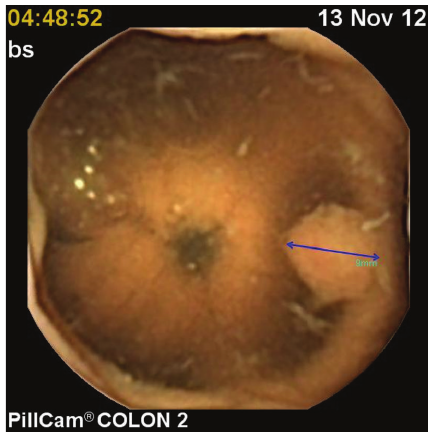
Figure 3: Image of polyp (blue arrow) in transverse colon.